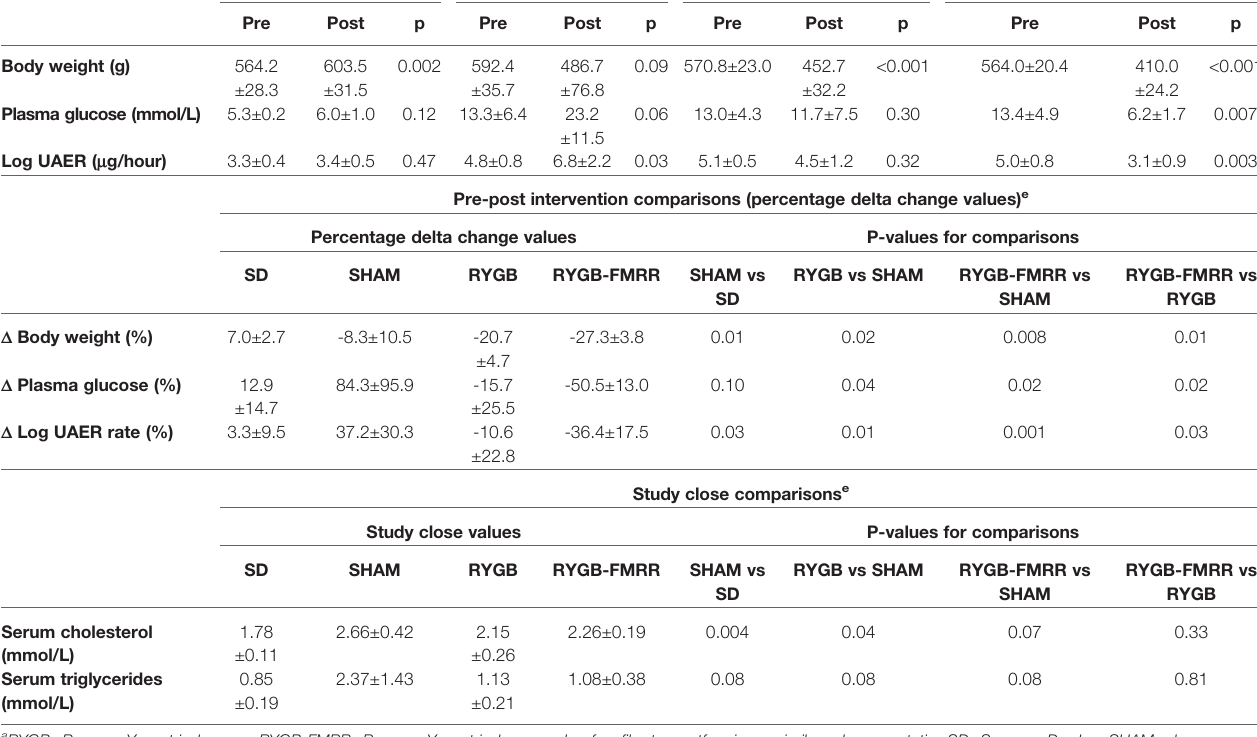
Pre-post intervention comparisons (absolute values)